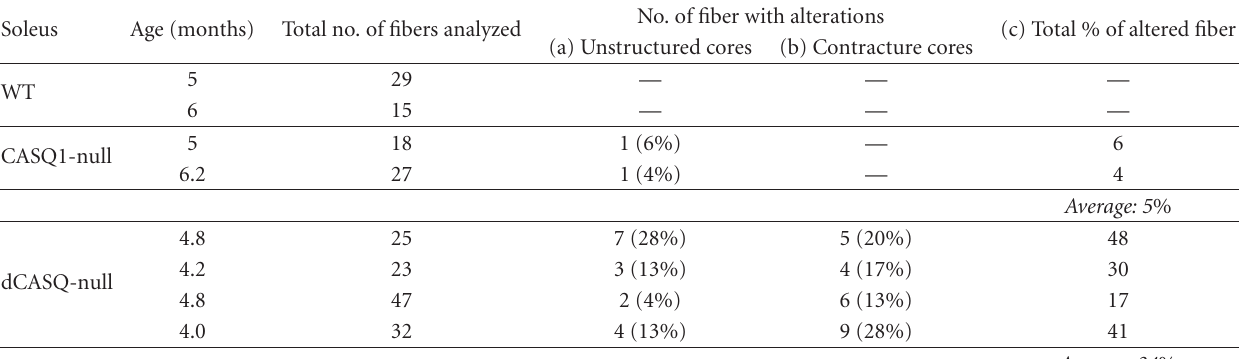
Table 1: Histological examination of adult Soleus fibers: fibers presenting structural damage were absent in WT, rare in CASQ1-null, but quite frequent in dCASQ-null. We classified abnormal fibers in two main classes: (a) fibers presenting large areas loosing cross striation, or unstructured cores , but no contractures (see Figure 4(f)); (b) fibers containing (also) contracture cores (see Figure 4(e), asterisk). (c) About 35% of Soleus fibers from dCASQ-null mice present severe structural